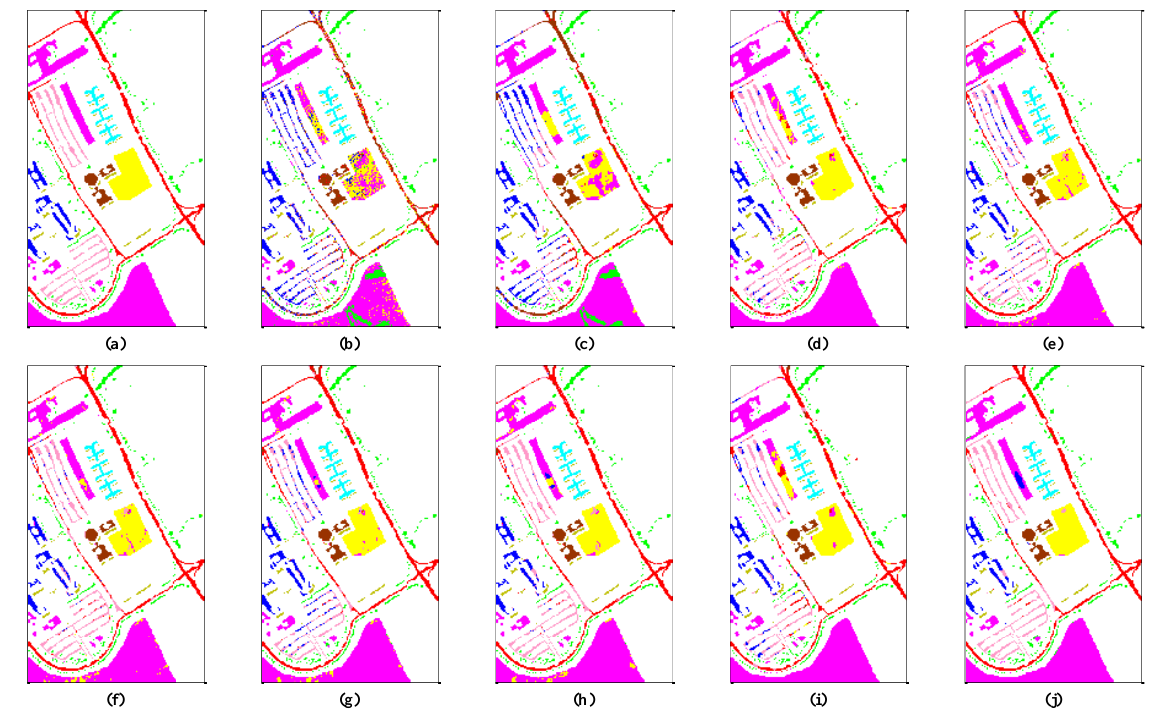
Figure 12. The OA, AA, and Kappa values for different methods on the Pavia University scene.